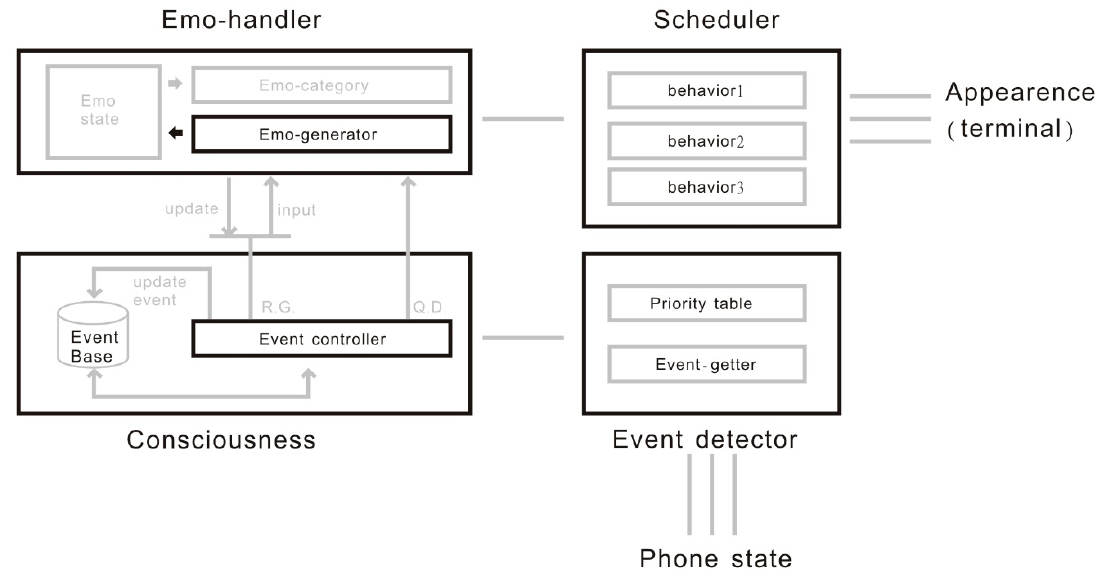
Figure 10. Schematic of the software architecture.